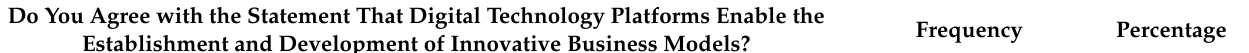
Table 7. The impact the DTPs have on the establishment and development of innovative business models.